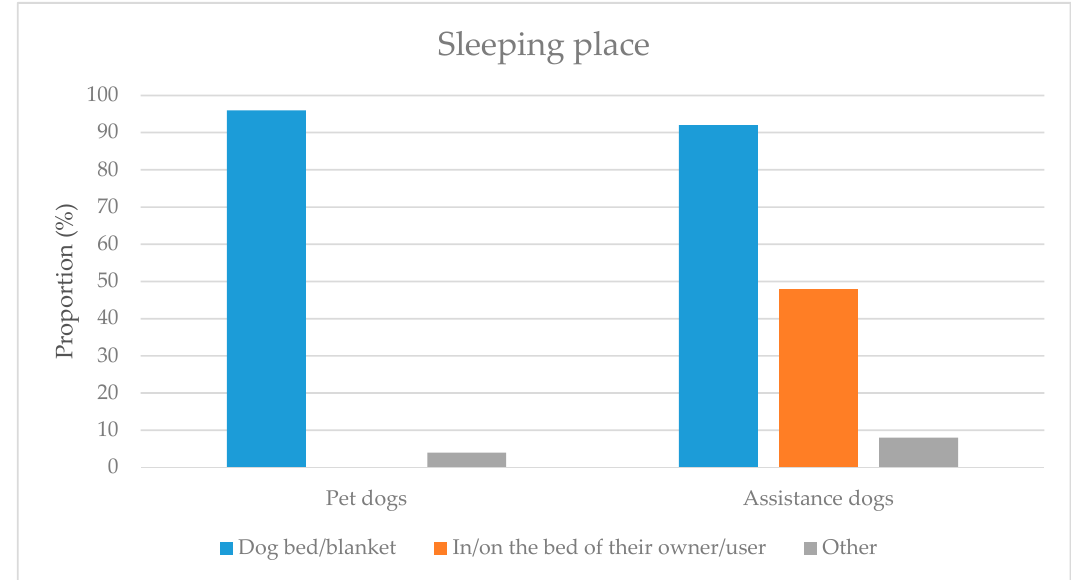
Figure 3. The sleeping places of pet dogs and assistance dogs.